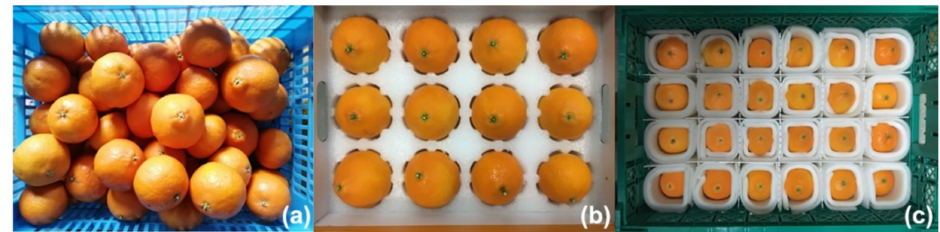
Figure 1. Three packaging formats for protecting Hongmeiren orange fruit during simulated and road transportation: ( a ) Reusable plastic containers (RPCs) for transportation of fruit in bulk (Packaging A). ( b ) Paper box with expandable polyethylene (EPE) as the internal packaging (Packaging B). ( c ) Self-designed packaging (Packaging